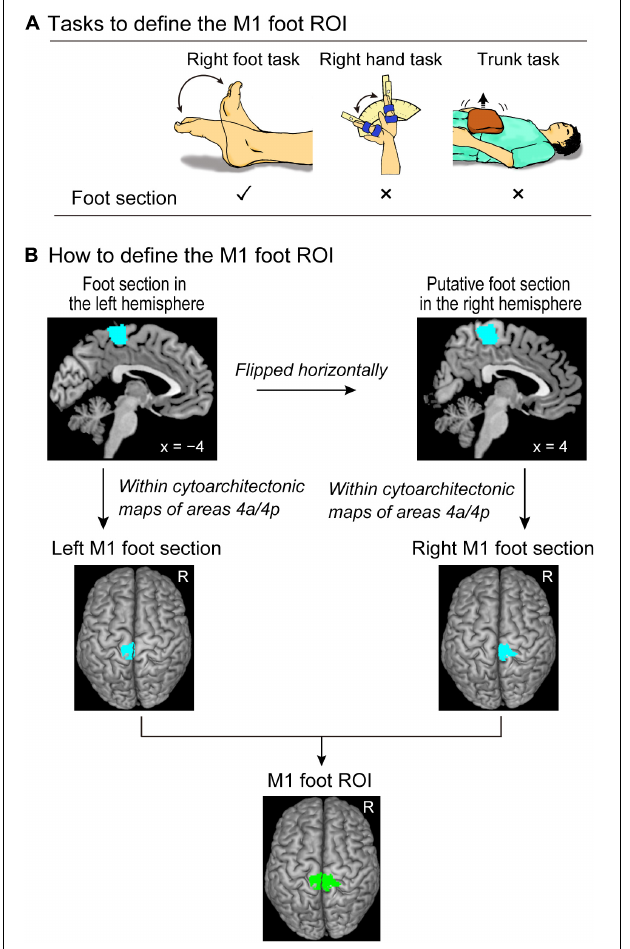
FIGURE 1 | Defining the M1 foot ROI. (A) Tasks to define the M1 foot ROI. We use the right foot, right hand, and trunk tasks to identify the brain regions that are activated during the right foot task, but not during the right hand and trunk tasks. (B) Procedures to define the M1 foot ROI (green section). Please see the text for details. M1, primary motor cortex; ROI, region-of-interest.